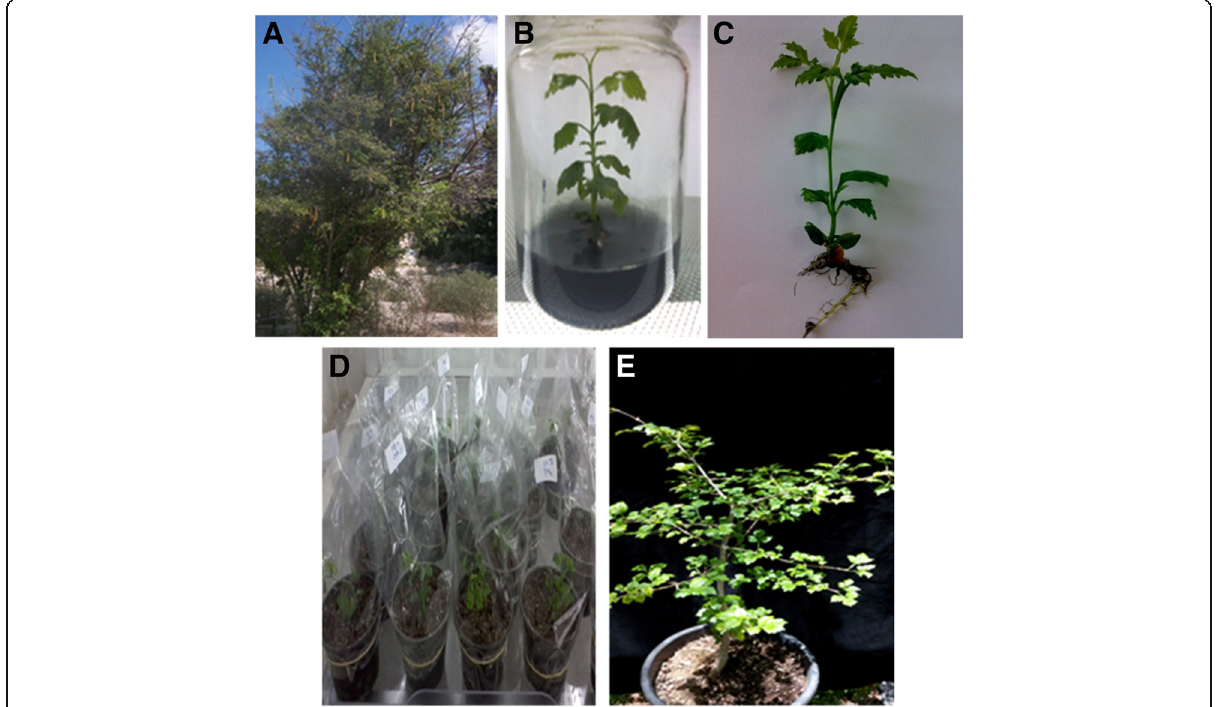
Fig. 1 a Mother tree. b Shoot formation. c Regenerated plants. d Whole plant established in the greenhouse